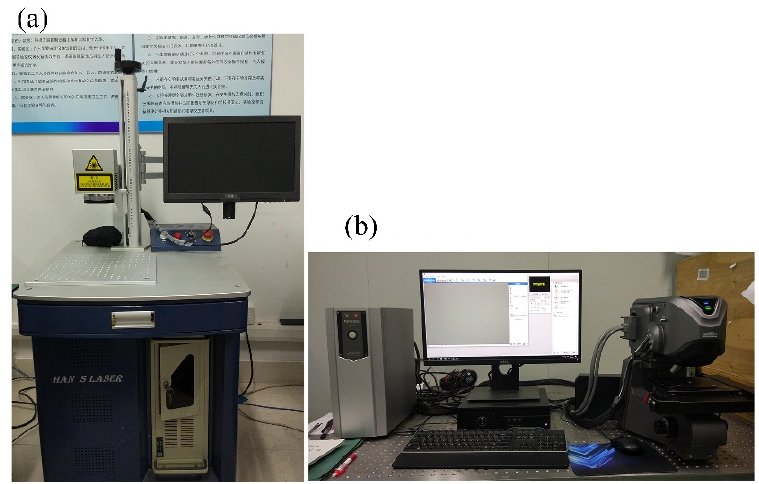
Figure 19. ( a ) Laser marking machine; ( b ) VK-X250 laser scanning microscope. Some of the parameters of the laser marking machine were set as shown in Table 4.